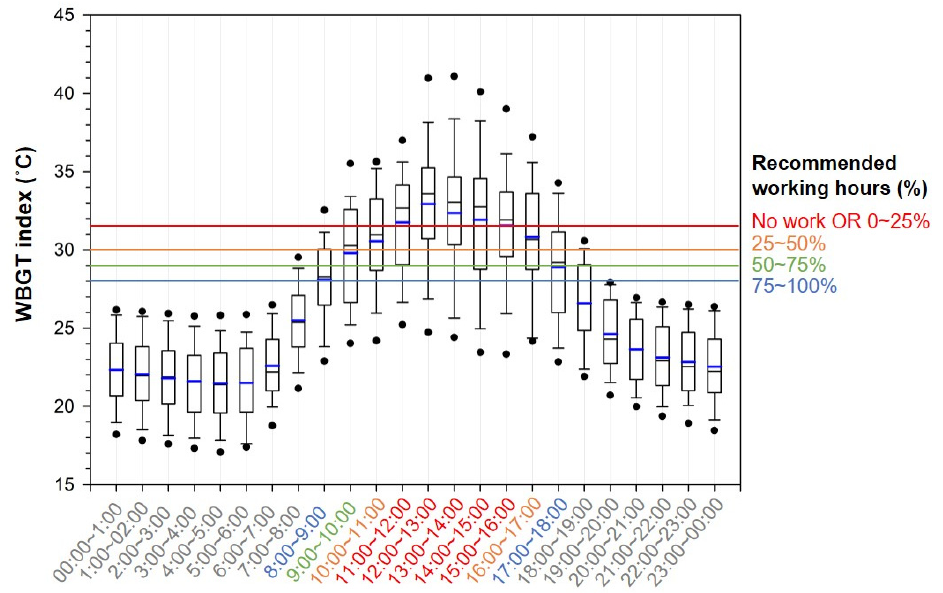
Figure 5. Recommended working hours during daily time in the greenhouse according to threshold limit values for moderate work (ACGIH, 2019).